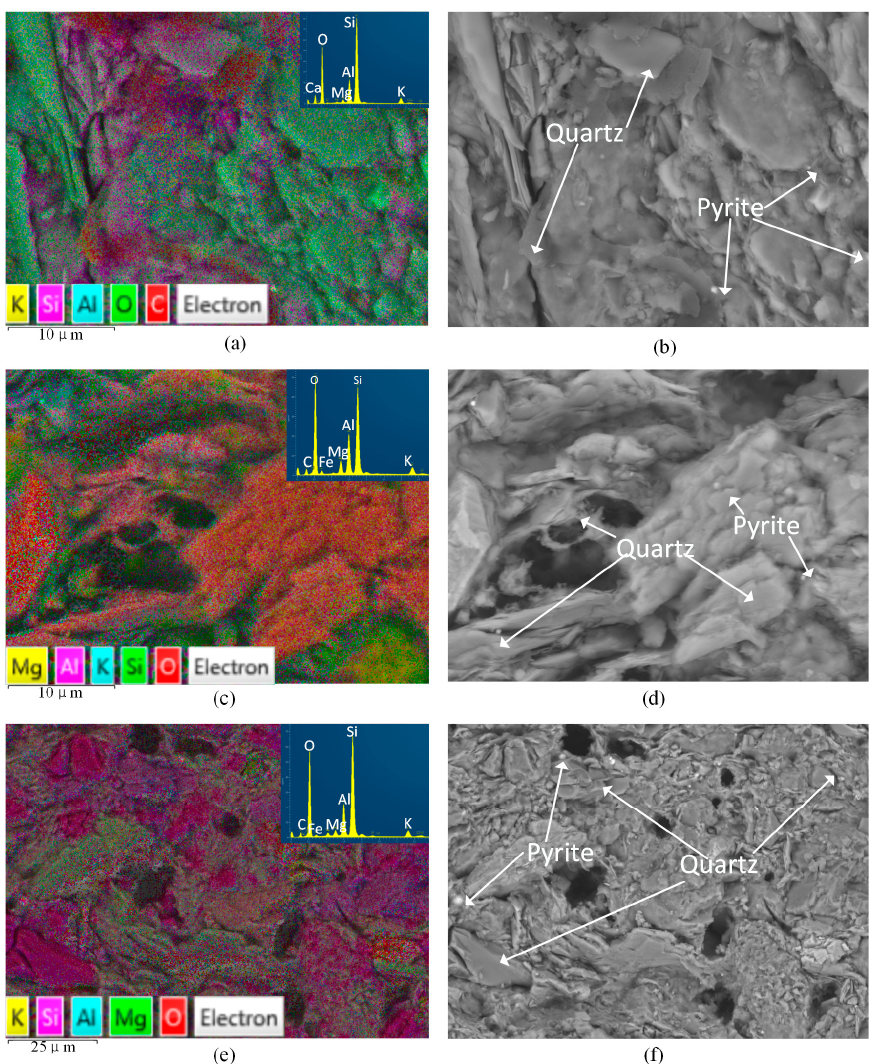
Figure 4. EDS images of samples without saturation and samples with water and gaseous/super-critical CO 2 saturation. ( a , c , e ) are chemical mapping and X-ray spectra; ( b , d , f ) are compacted SEM results.